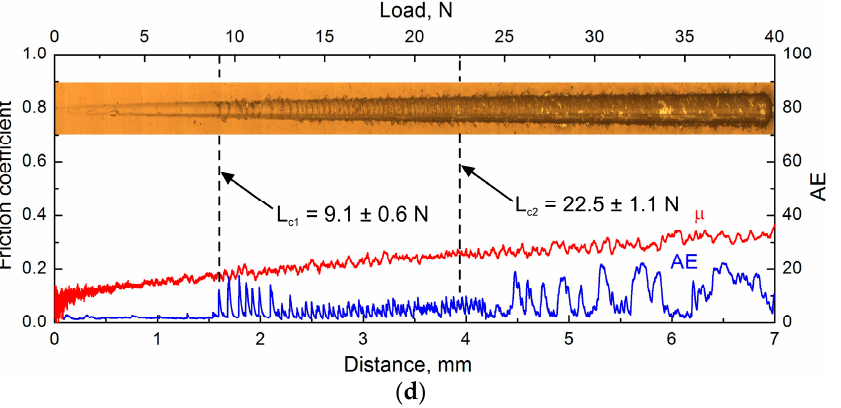
Figure 5. Friction coefficient ( μ ) and signal of acoustic emission (AE) as a function of a scratch length as well as optical micrographs of scratch tracks on the surface of the Ti-Al-Ta-N coatings obtained in different sputtering modes: ( a ) mode 1, ( b ) mode 2, ( c ) mode 3, and ( d ) mode 4.